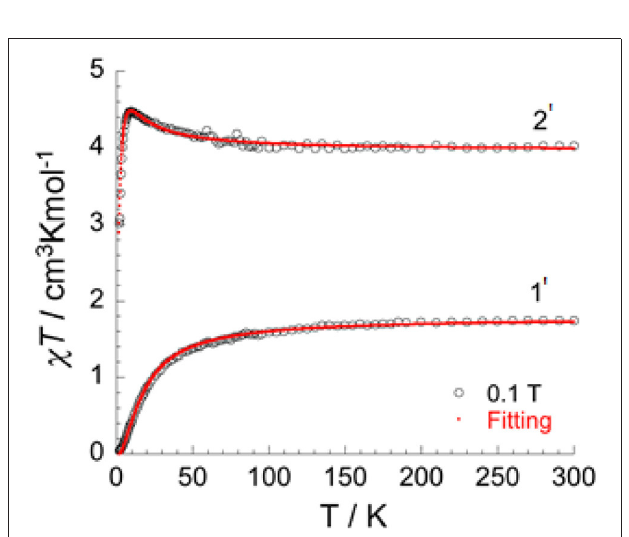
FIGURE 8 | Temperature dependence of χ T under 0.1T applied field for two differently aged samples of [V III 2 ( N 1 -pydpt) 2 Cl 6 ] · 2MeCN 4: partially oxidized sample [(V IV O) 0.84 (V III ) 1.16 ( N 1 -pydpt) 2 Cl 5.16 ] · 0.84H 2 O · 1.16MeCN (5) and fully oxidized sample [(V IV O) 2 ( N 1 -pydpt) 2 Cl 4 ] (6) (aged 14 months stored in air) in which complete oxidation to V IV V IV has